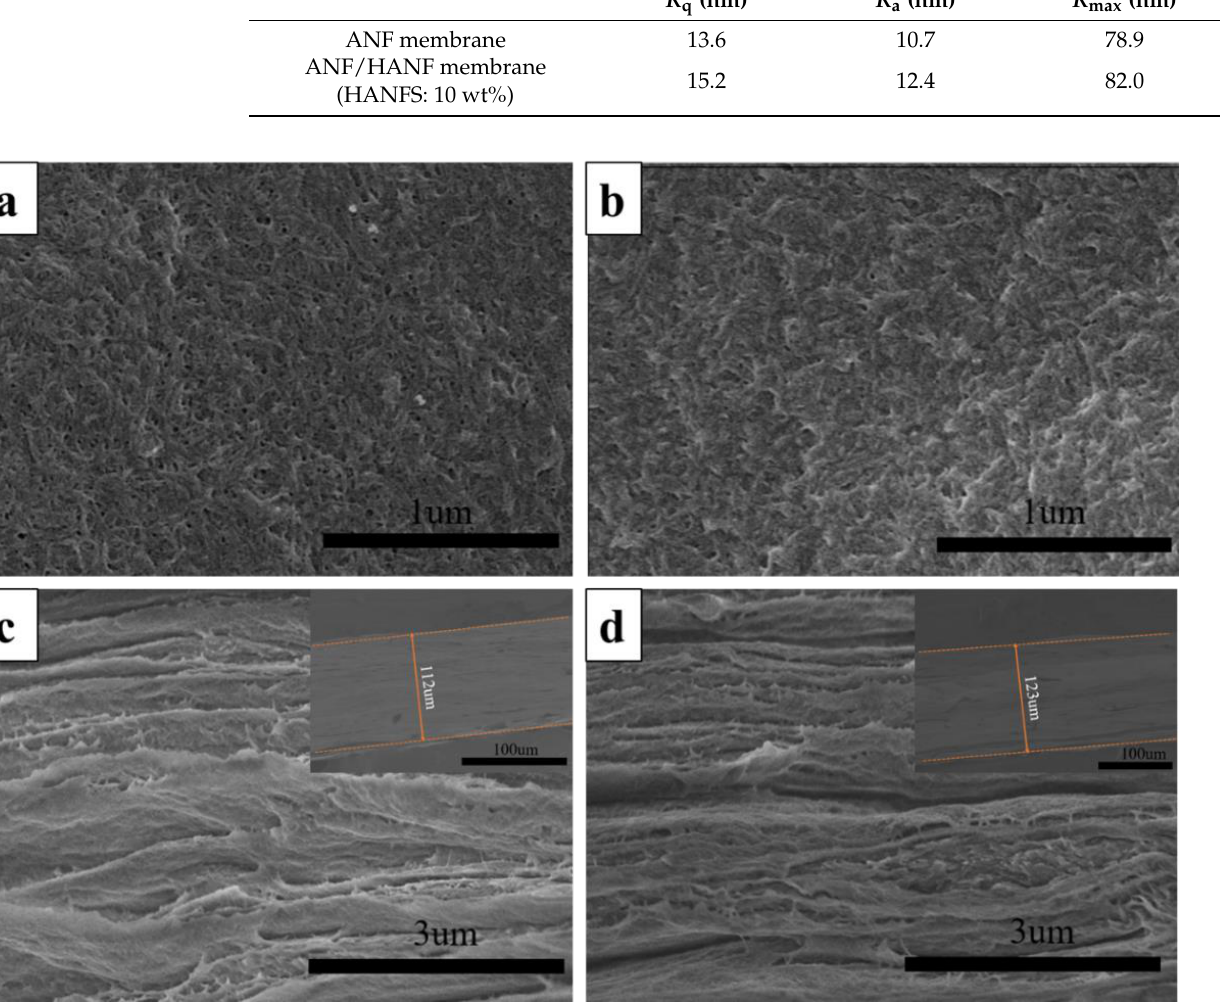
Figure 3. ( a ) Water fluxes at different pH values across pure ANF membranes and ANF/HANF membrane (HANF composition: 10 wt%). ( b ) BSA retention ratios at different pH values across